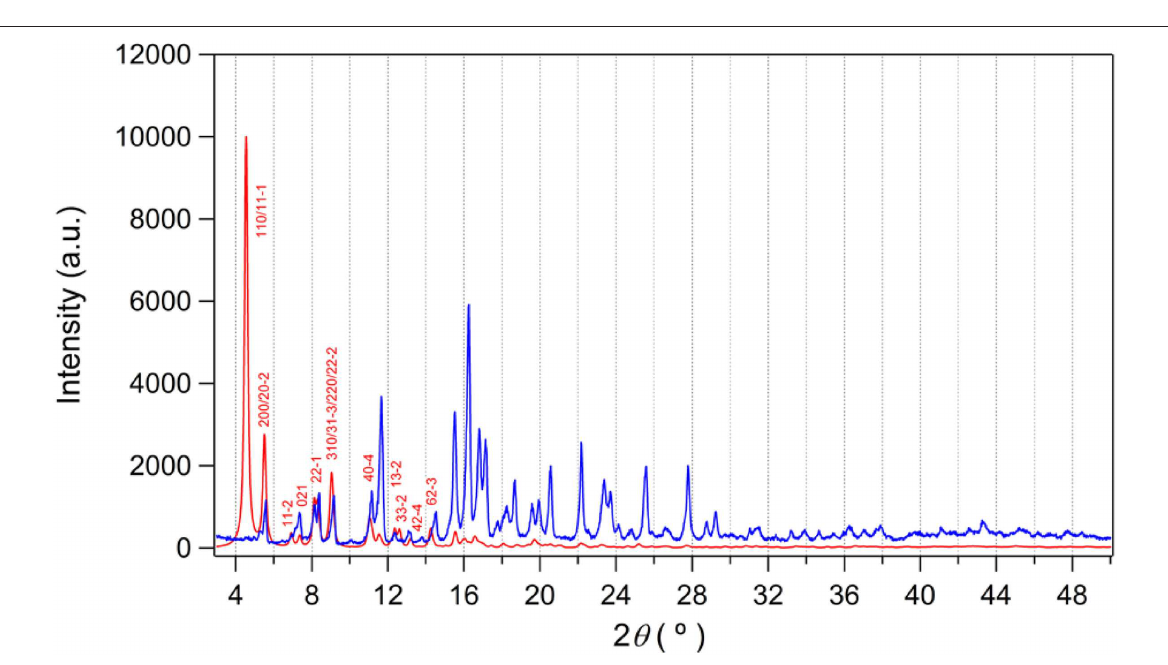
are formed along the c -axis and a -axis, respectively, and square grid channels are formed along the b -axis. The PXRD pattern of the dried sample showed almost identical pattern compared to that of the as-prepared I ( Figure S3B ) and this indicated the framework did not collapse during desolvation process. Thus,